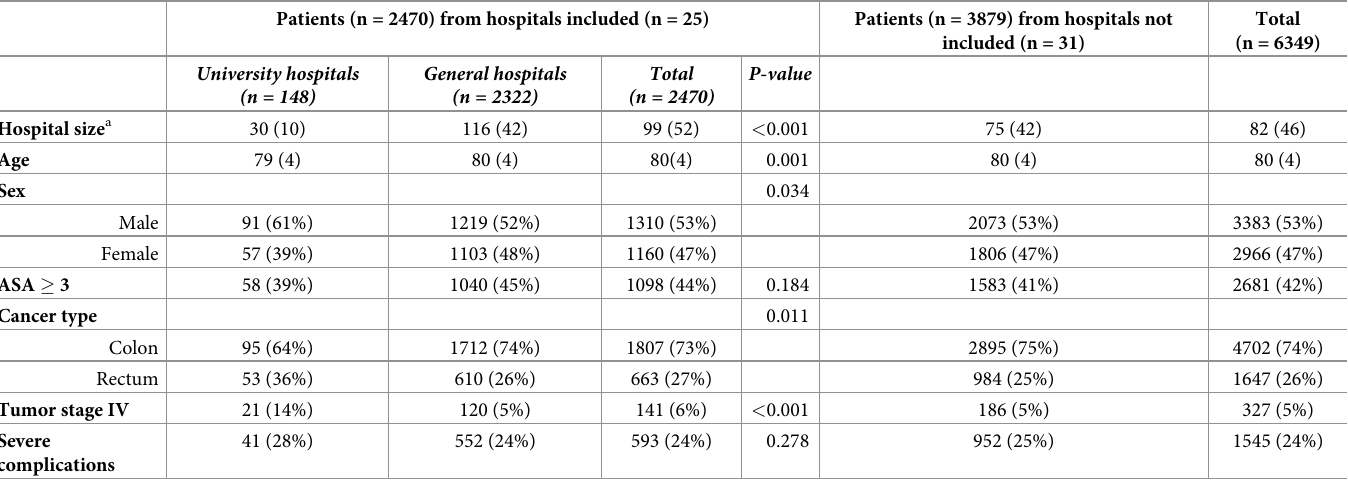
Data are n (%) or mean (SD). a Average number of treated patients in each hospital in